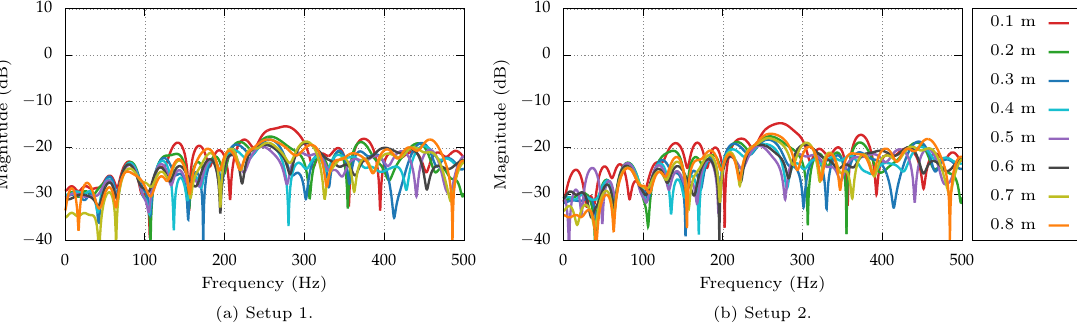
Figure 12. The amplitude functions of the frequency functions of the impulse response estimates for the paths between right casing panel’s selected actuator and one of the room microphones, at all distances, in both setups.